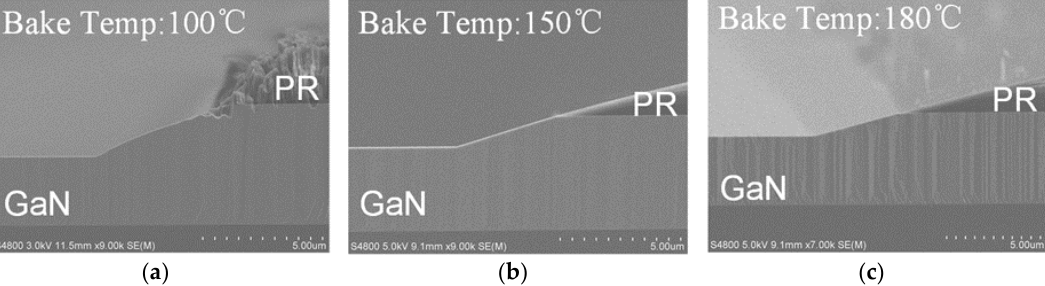
Figure 3. Cross scanning electron microscope (SEM) photomicrographs of GaN mesa sidewalls etched with a PR mask under Cl 2 plasma conditions with 1.5 Pa pressure and 130 sccm flow rate. ( a ) Reference sample. ( b ) High RF-power etched sample. ( c ) High ICP-power etched sample.